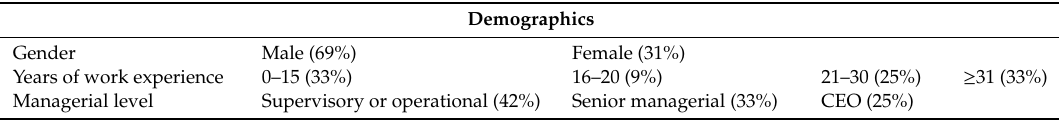
Table 6. Demographics for focus